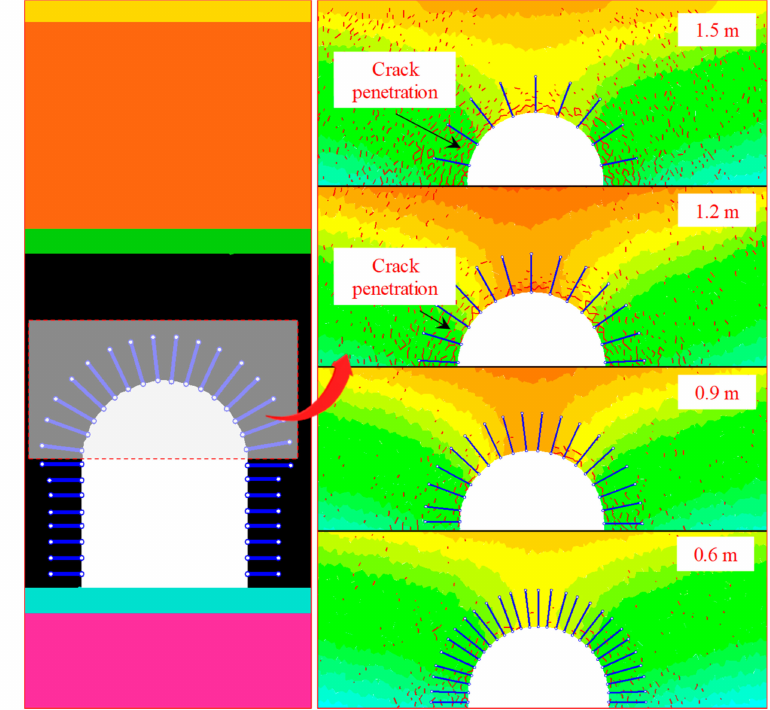
Figure 15. E ff ect of bolt spacing on the crack development in the chamber